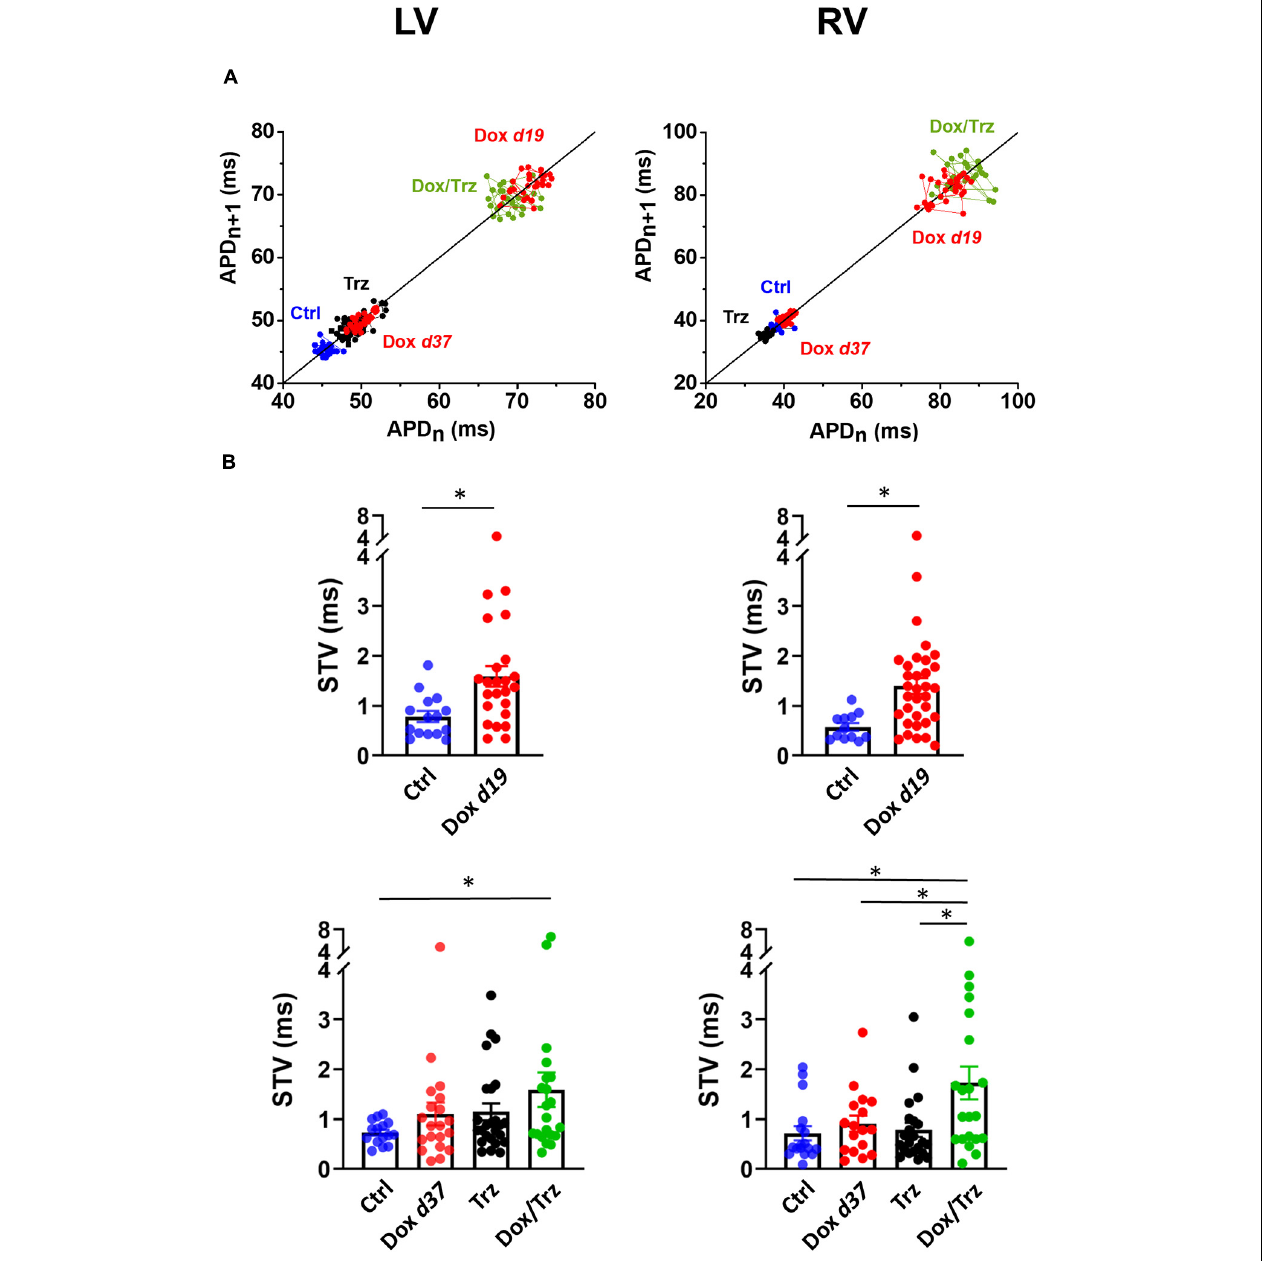
FIGURE 4 | Effects of Dox and Trz on beat-to-beat variability of repolarization (BVR). (A) Poincaré plots showing the dispersion of APD 90 values around the identity line in LV and RV CMs in all groups. (B) Quantitative analysis of short-term variability (STV) of APD values. STV was increased in the Dox group at d19 and in the Dox/Trz group at d37. Data are shown at d19 and at d37. Unpaired Student’s t -test and one-way ANOVA was used to test for significant differences at d19 and d37, respectively. Bars are mean ± SEM ( n = ≥ 12 from ≥ 3 rats/group; ∗ p <